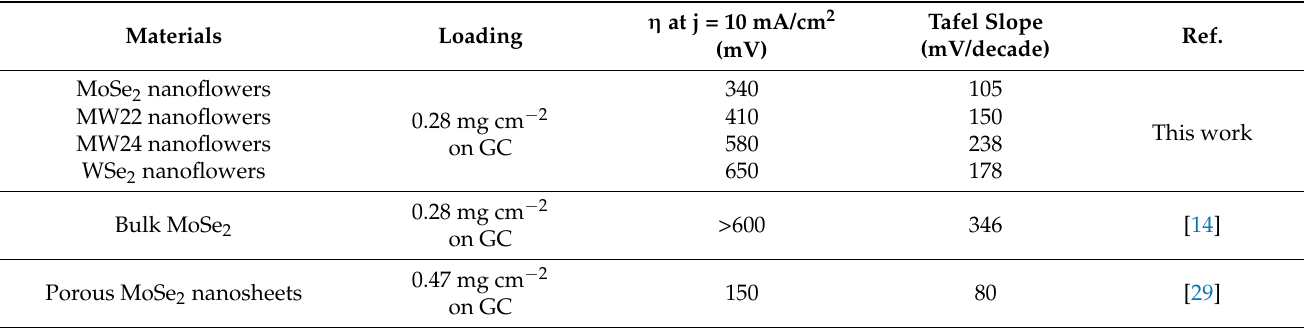
Table 1. HER performance comparison of MoSe 2 -based nanostructure catalysts showing the overpotentials and Tafel slopes. Materials